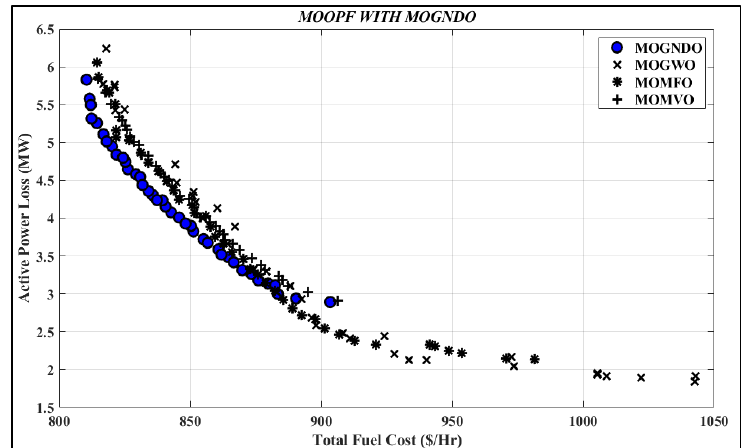
Figure 21. PF of TFC and APL minimization.